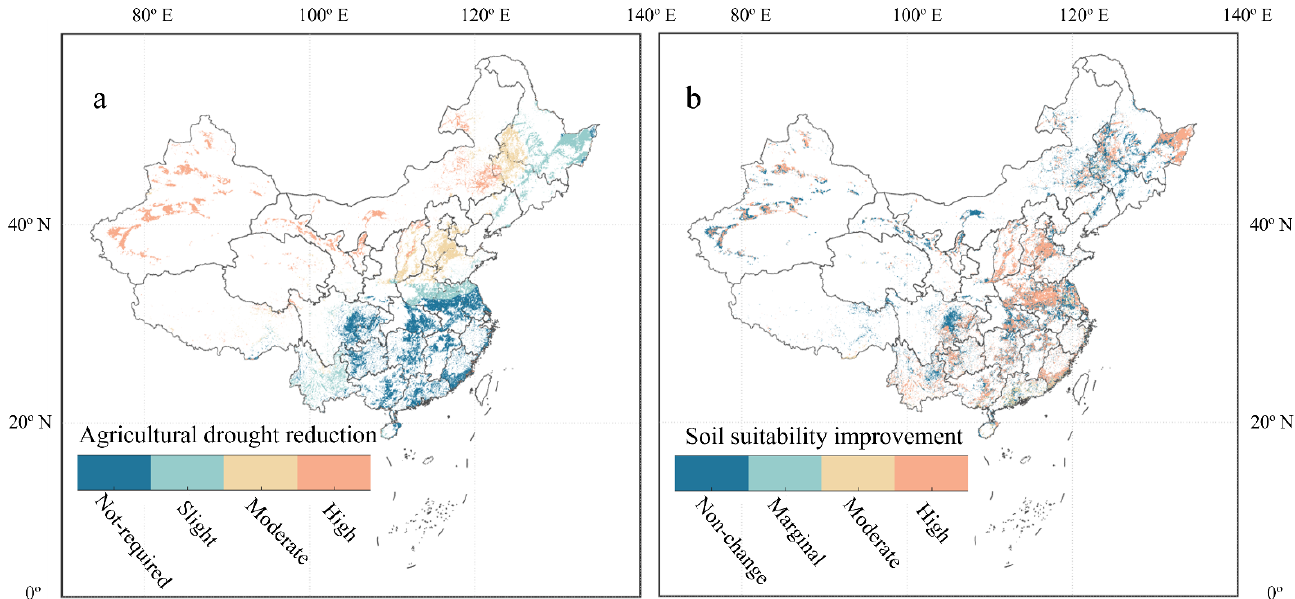
Figure 10. Potential drought reduction ( a ) and soil suitability improvements ( b ) caused by irrigated cropland expansion between 2000 and 2019. Calculations can be seen in Appendix A.